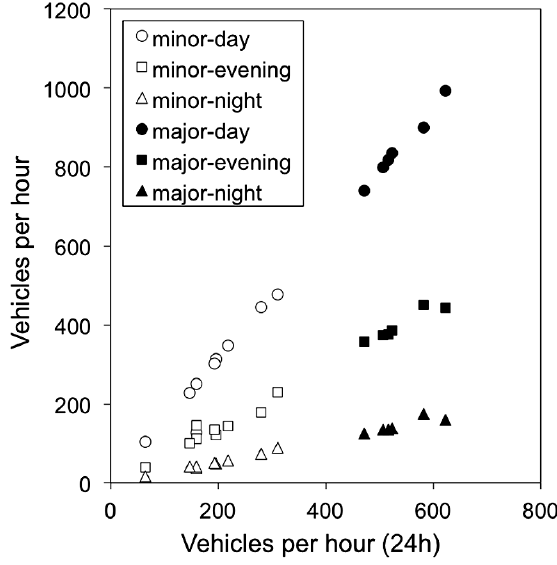
Fig. 4 . Traffic volume on Frisian major and minor roads, during different time periods of the day (exact time intervals are given in the text). Every data point represents the yearly average of the available data between 2001 and 2015 (the amount of which varied between years). The x-axis gives traffic volume per hour on a 24-hour basis. The y-axis depicts traffic volume for the indicated time intervals. Data provided by the Province of Friesland and Ministry of Infrastructure and the